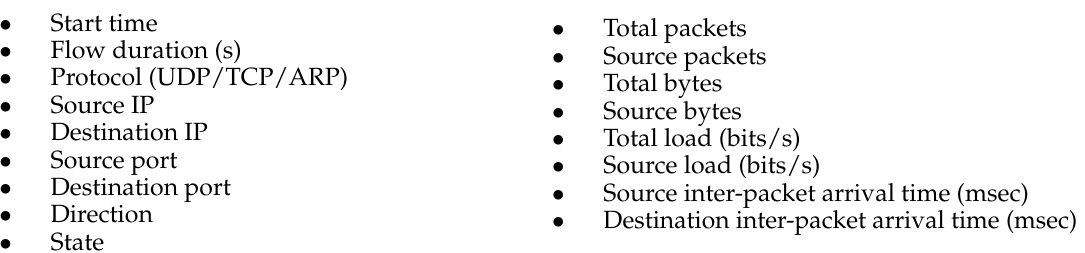
Table 2. Flow record fields obtained from the traffic